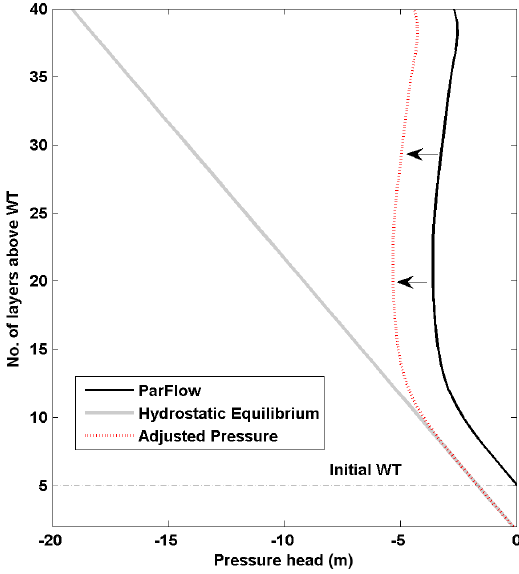
Figure 3. Adjusted pressure head distribution above the estimated DTWT from the DTWT function. Pressure head distribution of the last day of ParFlow. CLM spin-up simulation 6 was adjusted in ev- ery grid cell based on the position of DTWT estimated from the DTWT function. In this approach, the hydrostatic equilibrium as- sumption is used in regions between the new DTWT and the initial DTWT. The ParFlow.CLM pressure head distribution is adjusted to begin at the new pressure head from the initial WT, such that the vertical profile is maintained. Hydrostatic pressure head distribu- tion is shown as a reference for the new DTWT, which is lower than the WT in simulation